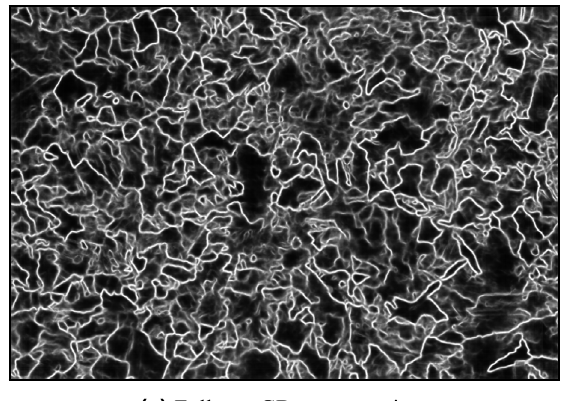
(a) Full raw GB segmentation.